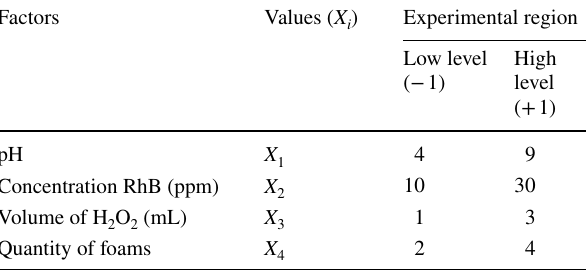
Fig. 1 Schematic representation of experimental setup